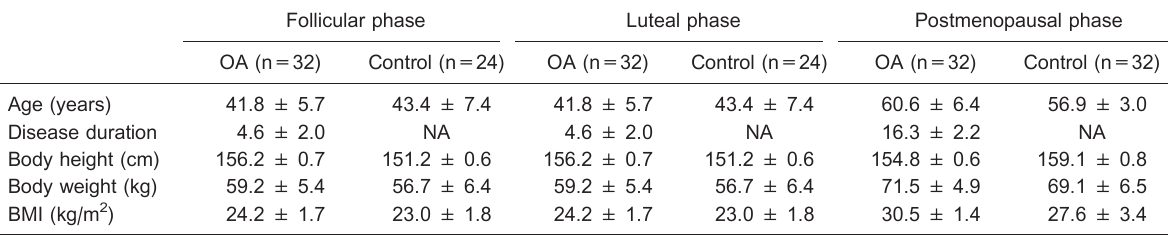
Table 1. Baseline characteristics of